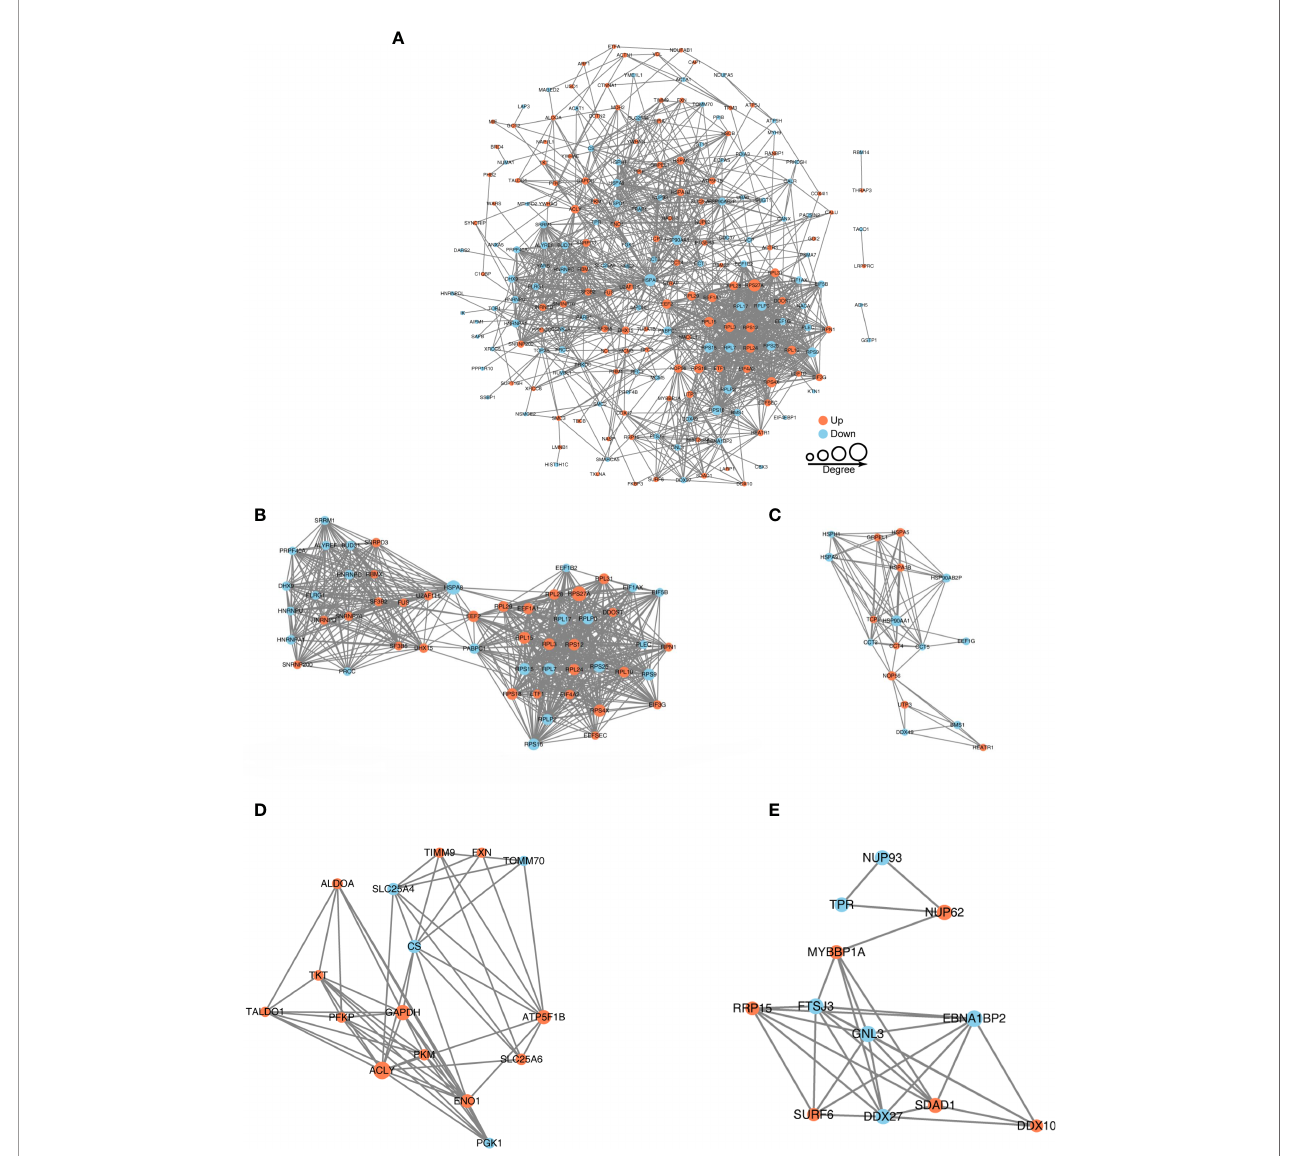
FIGURE 5 | Protein-protein interaction network of (A) all differentially crotonylated proteins. The clustering interaction network with MCODE tool (B) in Ribosome, (C) Endoplasmic reticulum, (D) Metabolic pathways and (E) RNA transport. Red nodes means up-regulated proteins, blue nodes means down-regulated proteins, the degree of nodes means the number of interacting proteins, the more protein nodes interacting with the protein, the node of this protein is